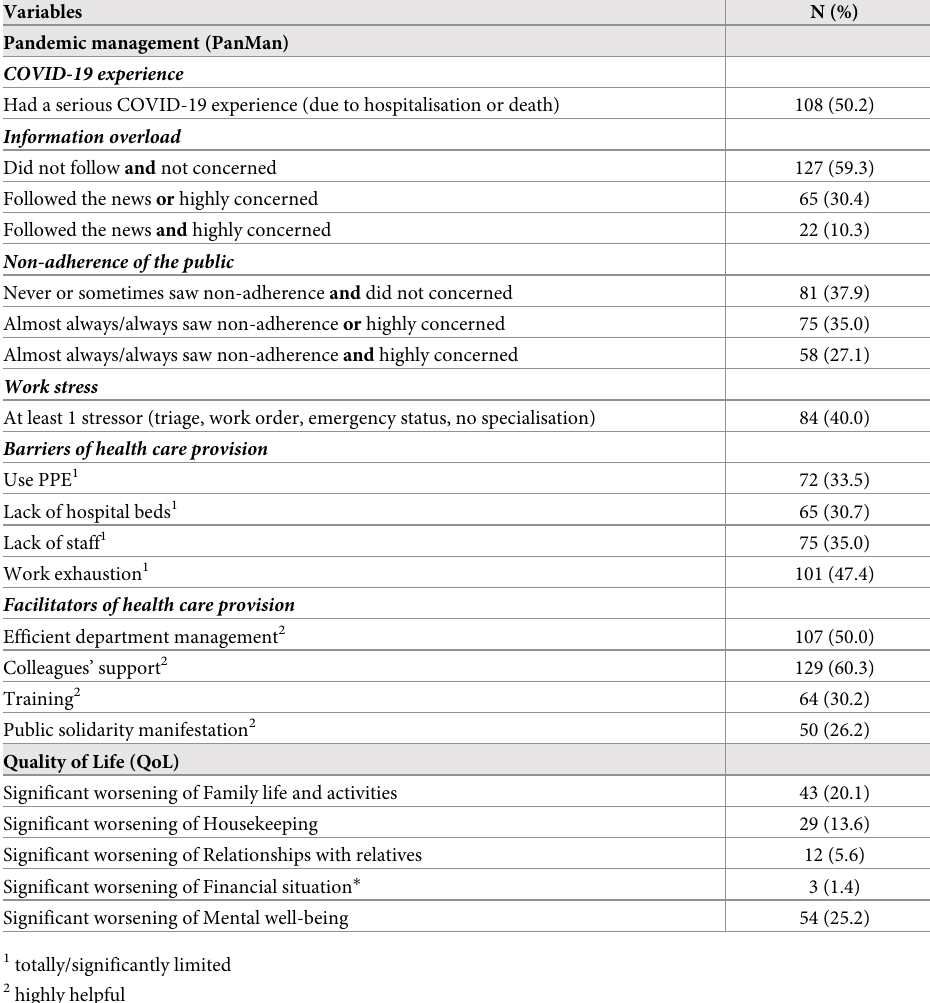
Table 2. Description of PanMan factors and QoL of Slovak hospital HCWs during the second wave of the pandemic. Variables N (%) Pandemic management